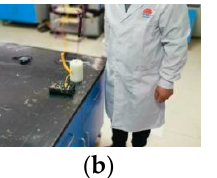
Figure 3. Images of new polyurethane composite materials under electron microscope.